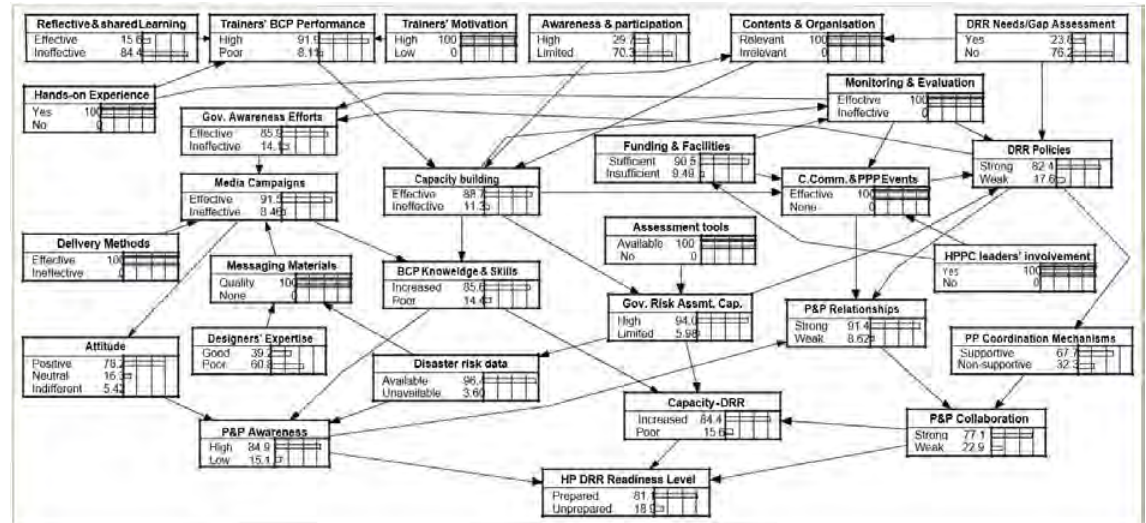
Figure 3. BayesianBelief Network (BBN) modeling for defining systemic interventions to achievethe end goal of disaster resilience. Notes: Yellow variable represents thegoal; Green variables represent sub-goals (expected outcomes); Red variablesrepresent leverage points for systemic interventions; Dark variables representsystemic interventions.temi